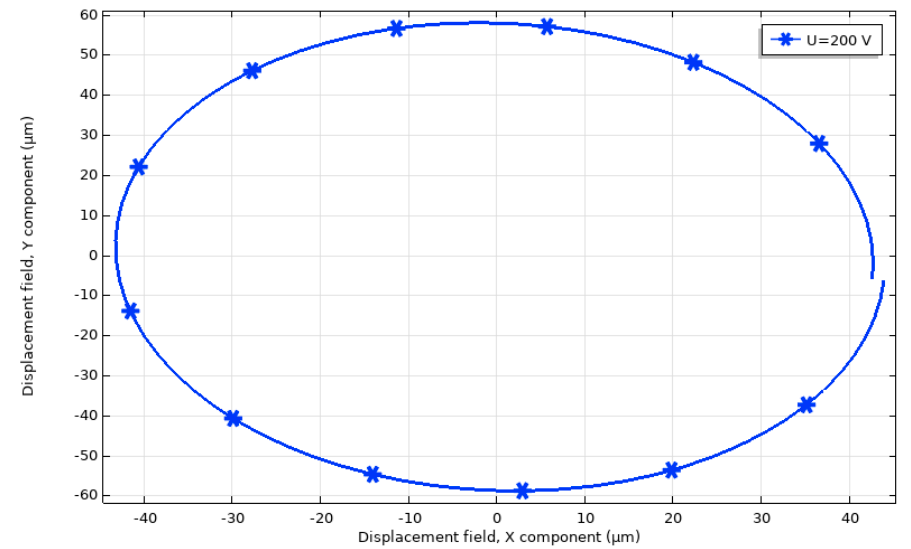
Figure 9. Contact point trajectories at different amplitudes of excitation voltage.